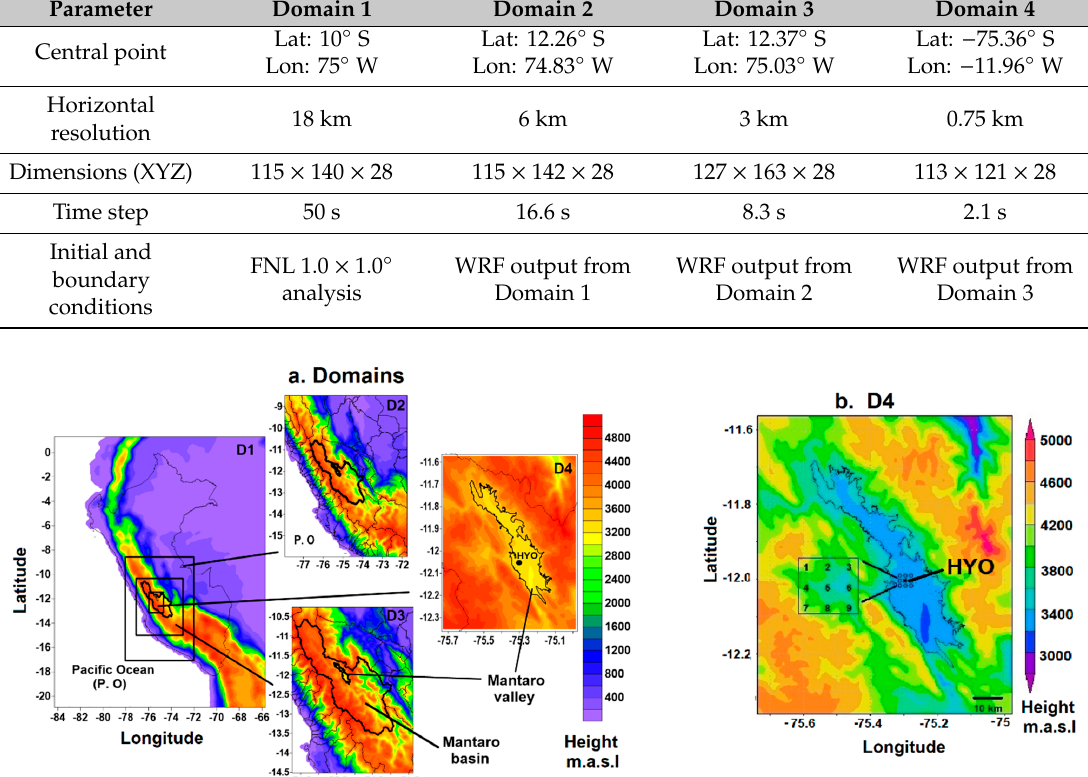
Figure 1. ( a ) Four nested domains whose parameters are described in Table 1. Domain 1 (D1): Perú, surrounding territories and the next Pacific Ocean. Domain 2 (D2): Central Andes, Domain 3 (D3): Mantaro river basin. Domain 4 (D4): Mantaro valley, ( b ) D4 with more details of the orography, including nine points used below to evaluate the simulated precipitation. Table 1. Main parameters of the four nested domains.